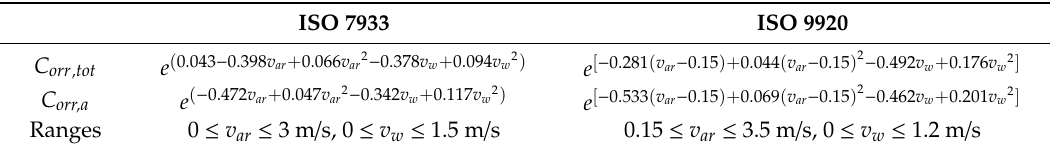
Table 1. Calculation of C orr,tot , C orr,a coe ffi cient of normal clothing (NC) according to ISO 7933 and ISO 9920. Relative velocity: v ar , walking speed: v w .